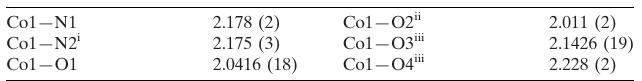
Selected bond lengths (A ˚ ).